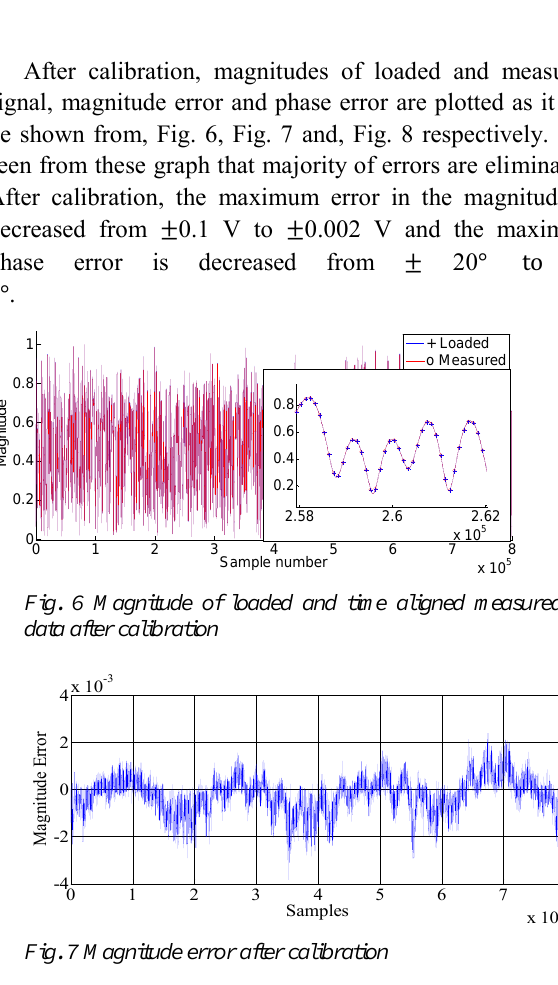
Fig. 5 Phase error between loaded and time aligned measured data under connection-1